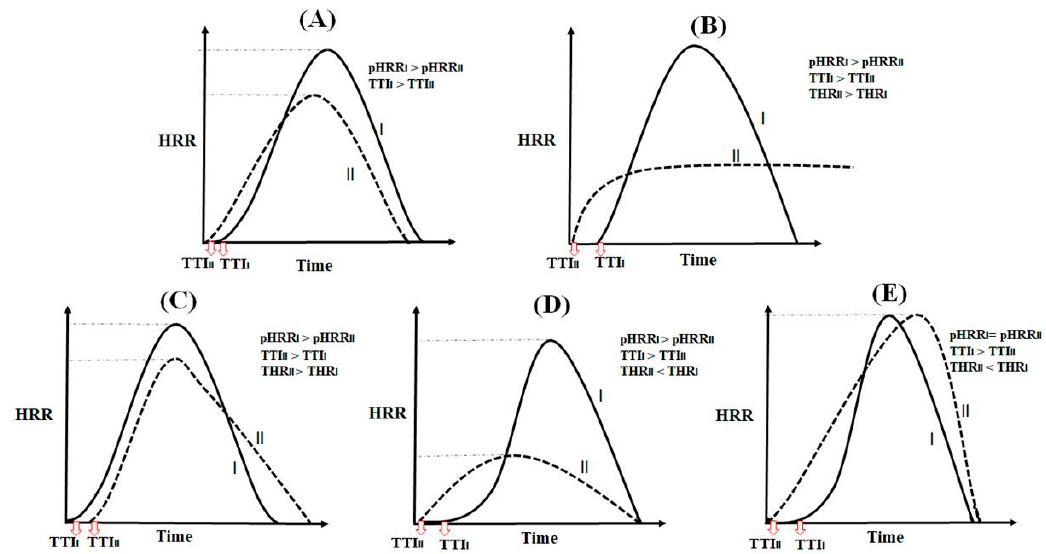
Figure 1. Possibilities in variation fashion of cone calorimetry HRR curves of given systems (I) and (II) that are likely to occur in different thermoplastics or in a given thermoplastic containing